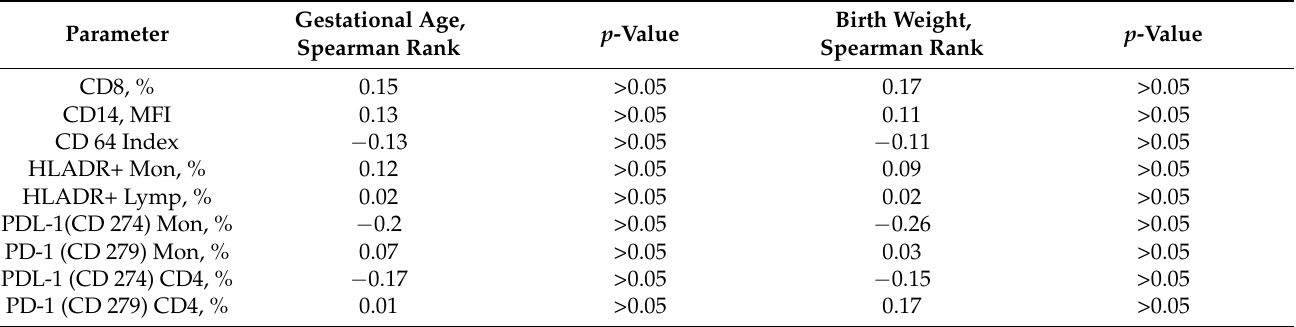
Table A1. Correlation analysis between the main cell subpopulations and gestational age or birth body